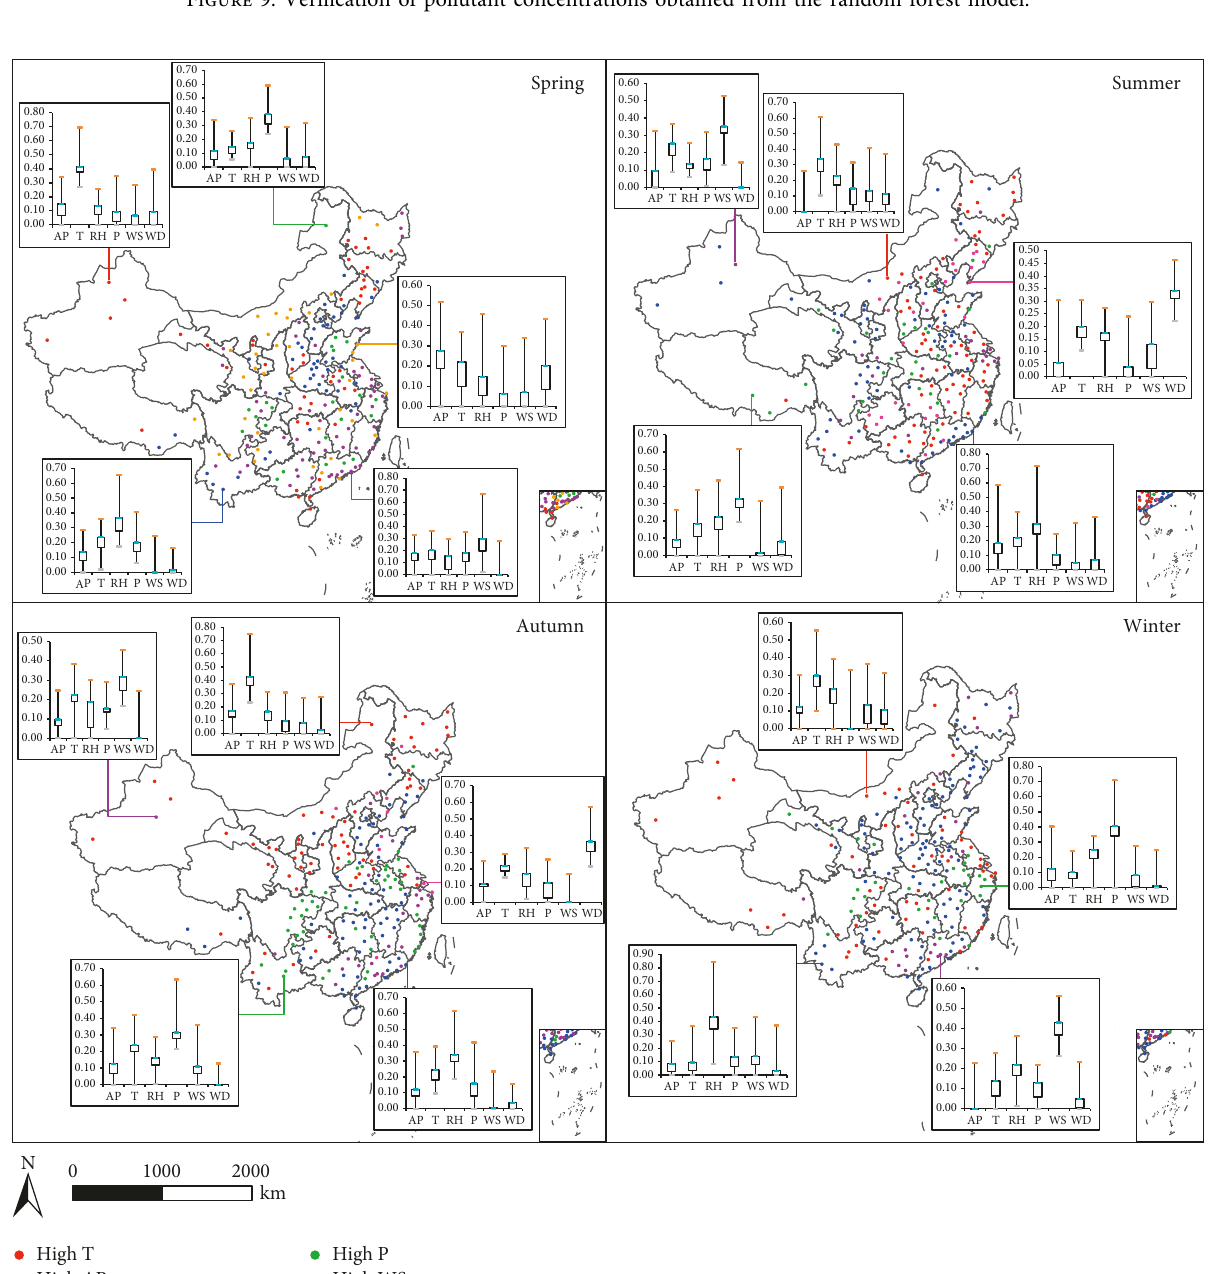
Figure 10: Relationship between PM 2.5 concentration and meteorological